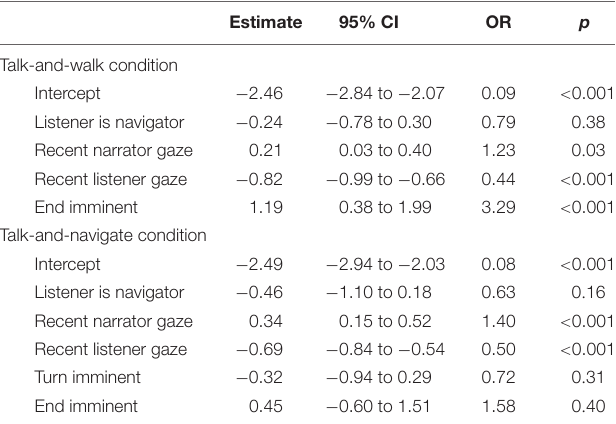
TABLE 2 | Mixed-effects logistic regression summaries for predictors testing the listener response hypothesis for non-verbal behavior (recent narrator gaze as predictor of listener gaze initiation), and the periodic-monitoring hypothesis (recent listener gaze as predictor for listener gaze initiation) in two